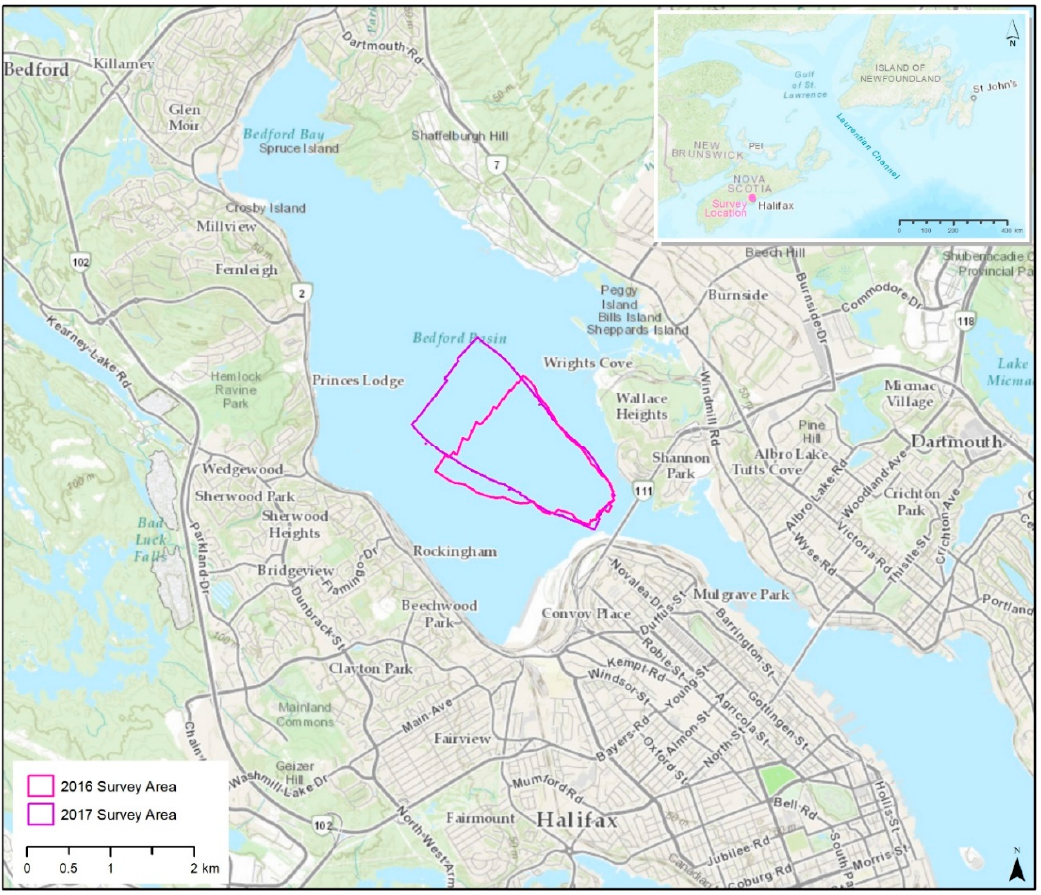
Figure 2. Overview map of the location of the 2016 and 2017 survey areas in the Bedford Basin, Nova Scotia, Canada .